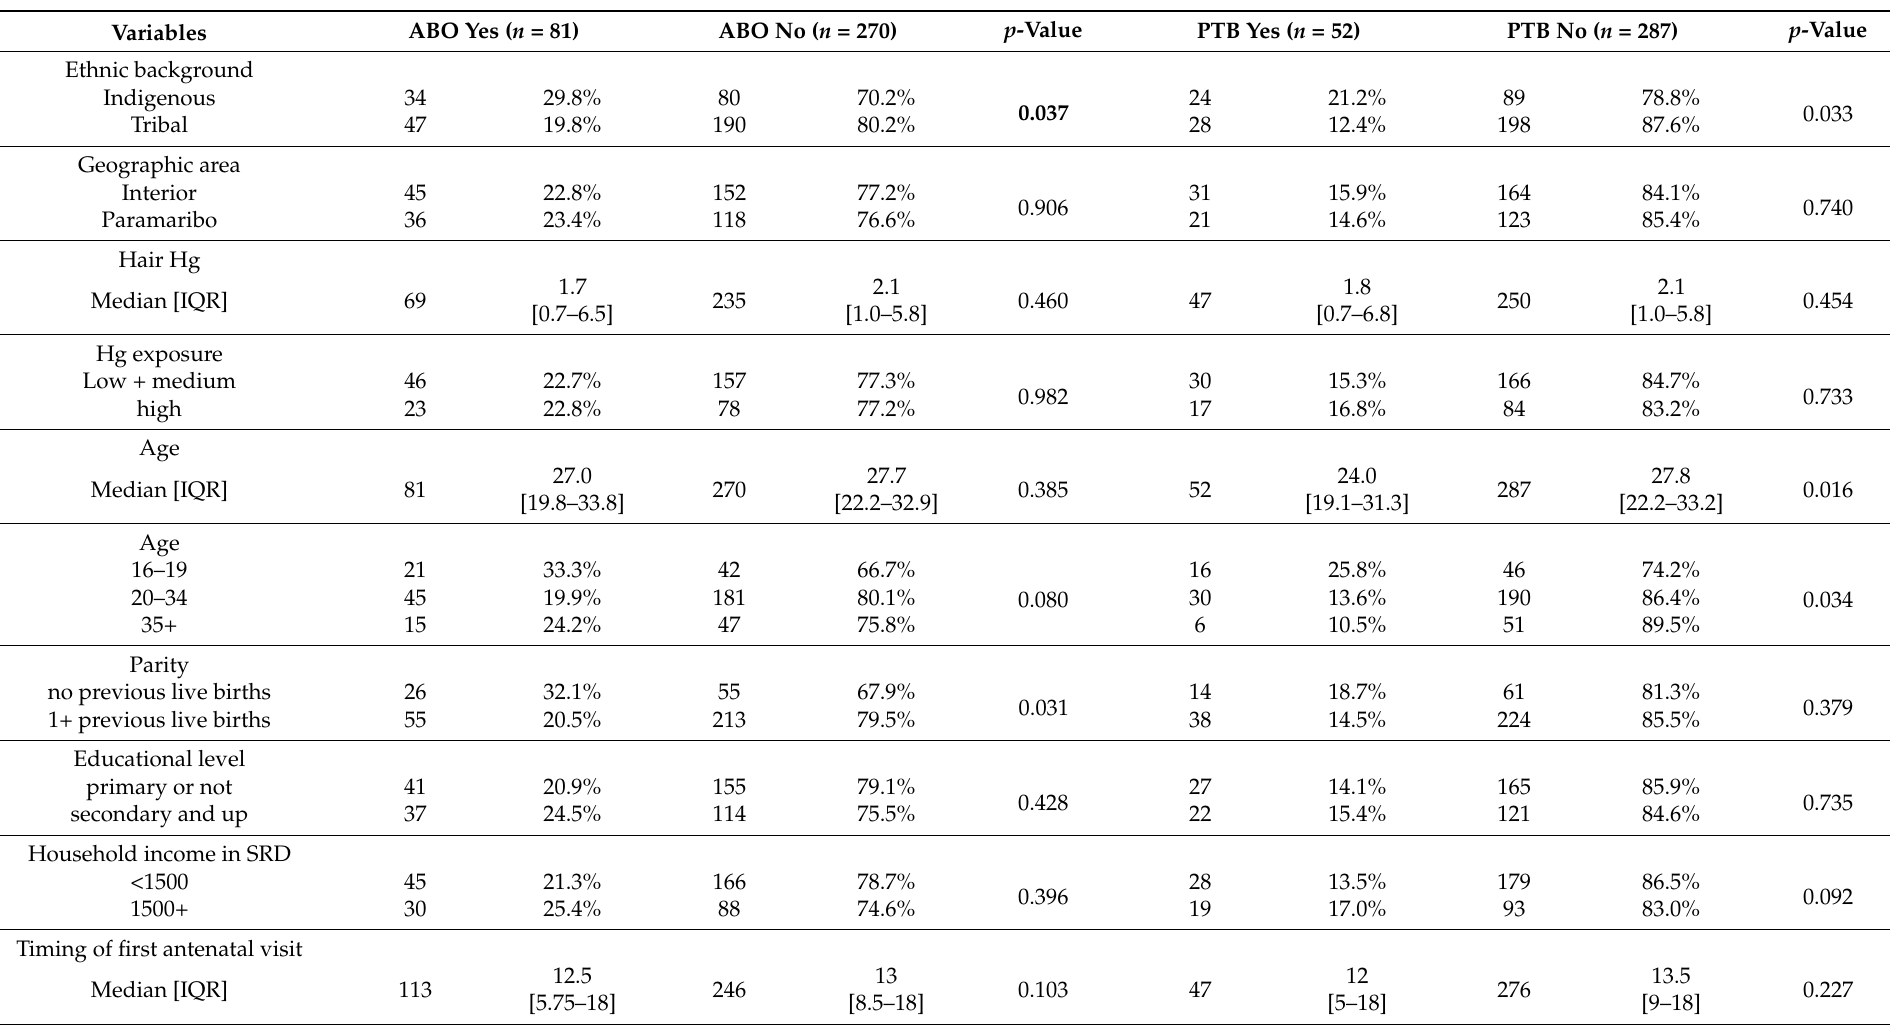
Table 3. Characteristics of participants stratified for adverse birth outcomes and for preterm